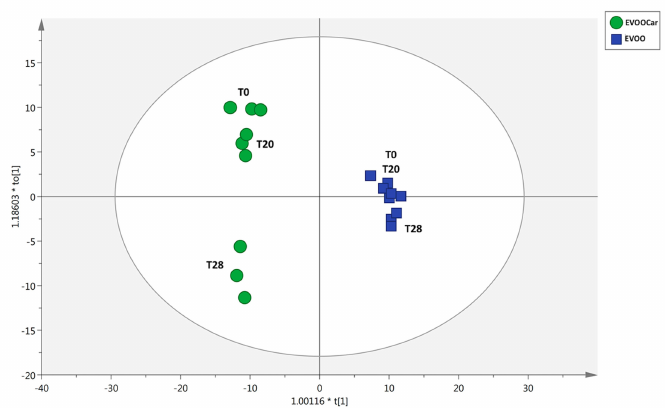
Figure 5. Orthogonal projection to latent structures discriminant analysis (OPLS-DA) on both EVOO and EVOOCar during long-term storage, considering time 0, 20, and 28 weeks. Individual replications are given in the class prediction model score